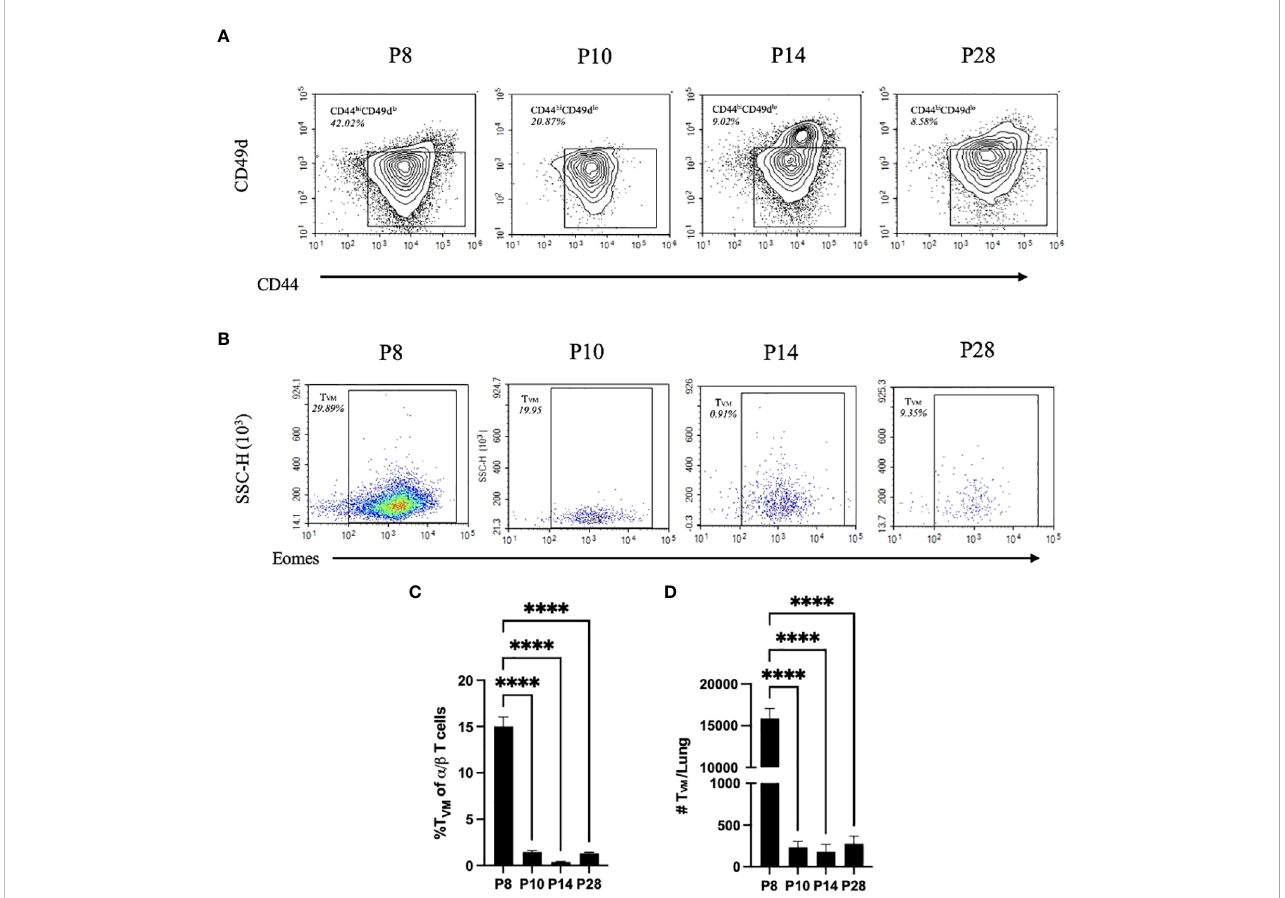
FIGURE 2 P10, P14, and P28 mice have signi fi cantly less T VM than P8 mice. CD44 hi CD49d lo T cell populations from the lungs via gating strategy in Supplementary Figure 3. Proportion represented is frequency of CD44 hi CD49d lo T cells in a population of CD4/CD8 single positive a / b T cells (A) . Eomes expression from CD49d lo CD44 hi CXCR3 + populations. Proportion represented is frequency of T VM (CD49d lo CD44 hi CXCR3 + Eomes + ) in a population of CD44 hi CD49d lo T cells (B) . Proportions of T VM of CD4/CD8 single positive a / b T cells in the lungs from naïve P10, P14, and P28 mice (C) . Numbers of T VM in the lungs from naïve P10, P14, and P28 mice (D) . (n=4 per group). Error bars show standard error of the mean. Statistical signi fi cance was calculated via One-way ANOVA. ns p> 0.0332 ****p<0.0001.